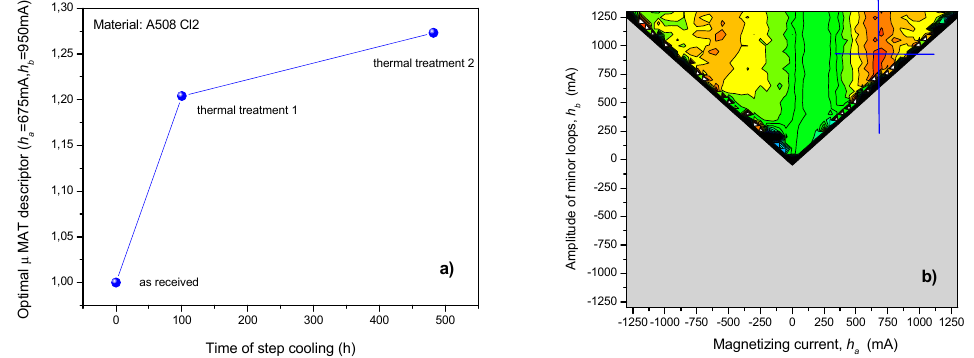
Figure 6. ( a ) Optimally chosen normalized MAT descriptor as a function of the time of step cooling for A508 Cl2 material; ( b ) the corresponding map of sensitivity, which shows the position of this descriptor.